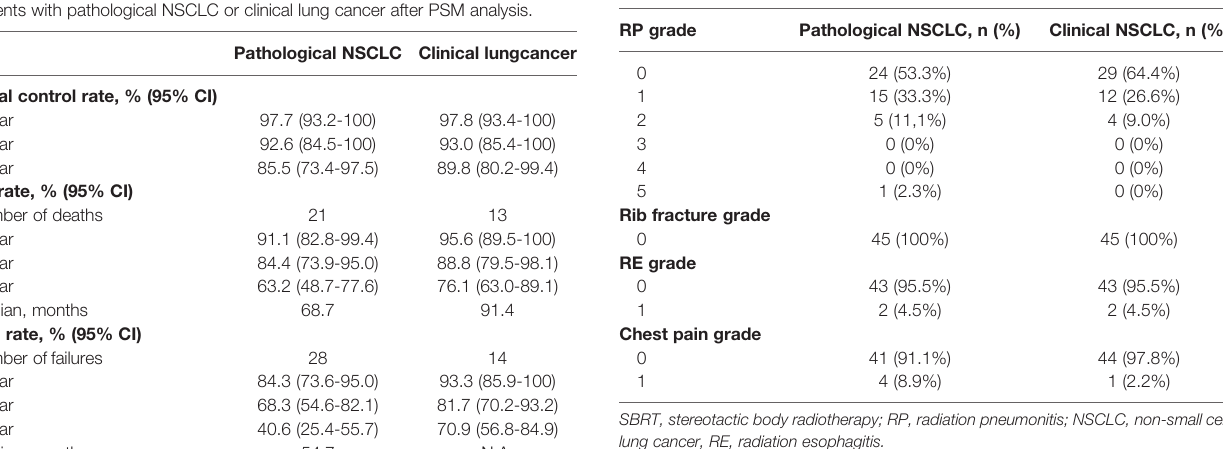
TABLE 4 | Adverse effects related to SBRT following PSM